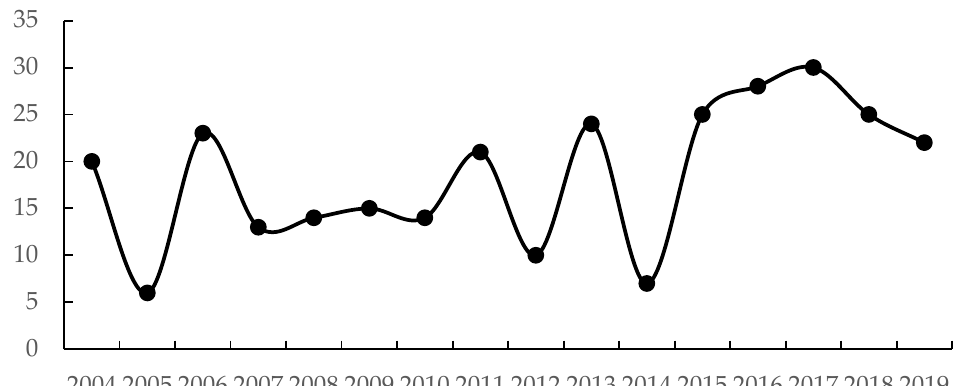
Figure 6. Number of provinces included in category D during the study period.